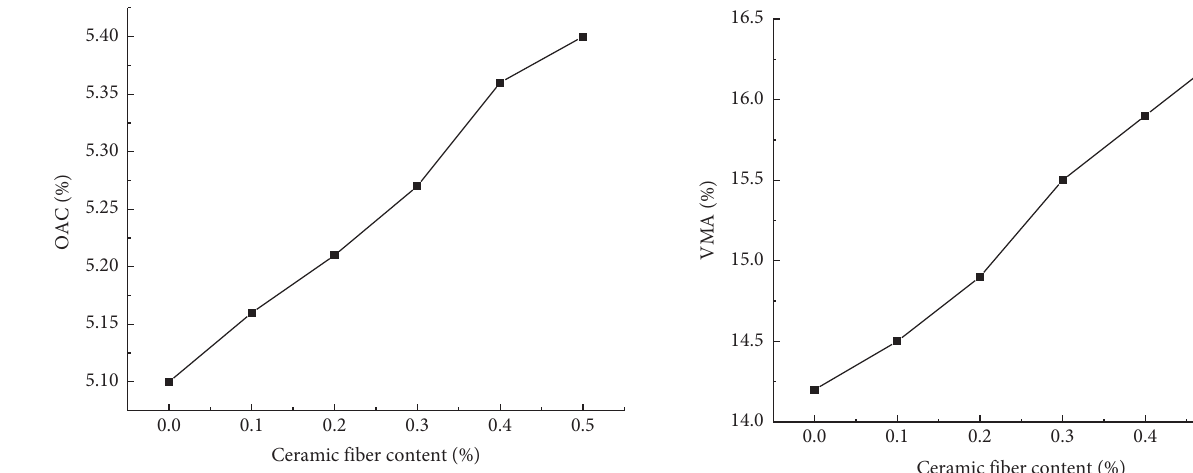
Figure 3: Relation between OAC and CF content.